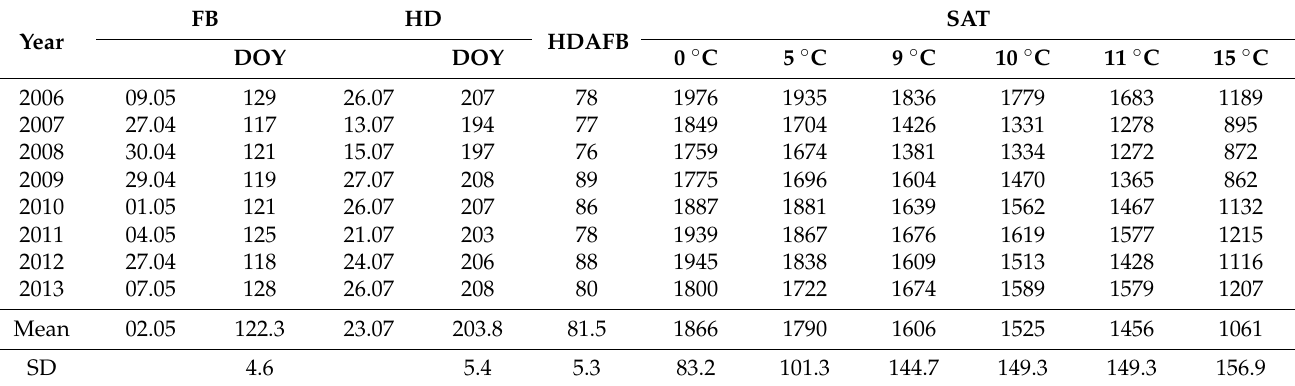
Table 13. Dates of full bloom, harvest and sum of active temperatures for sour cherry cv. ‘Łutówka’.